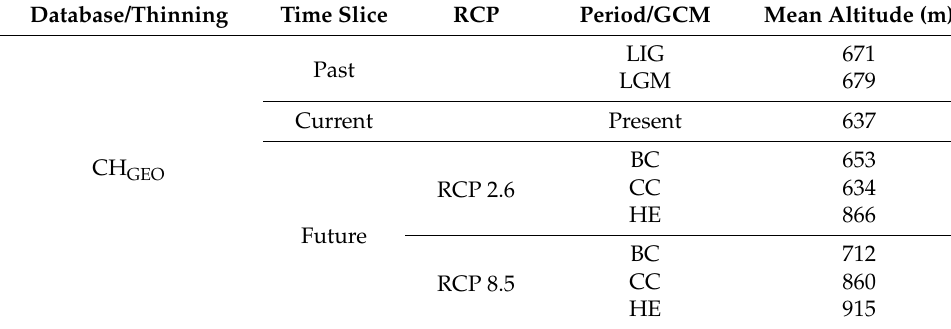
Table 3 . Mean altitude for past, present and future projections of Ophrys helenae distribution. For the past, Last Interglacial and Last Glacial Maximum (LIG and LGM, respectively) are presented, while for the future, all selected Global Circulation Models (GCMs) and Representative Concentration Pathways (RCPs). BC: BCC-CSM-1, CC: CCSM4, HE: HadGEM2-ES. The presented values are for the CHELSA climatic database and geographical thinning procedure (CH GEO ).